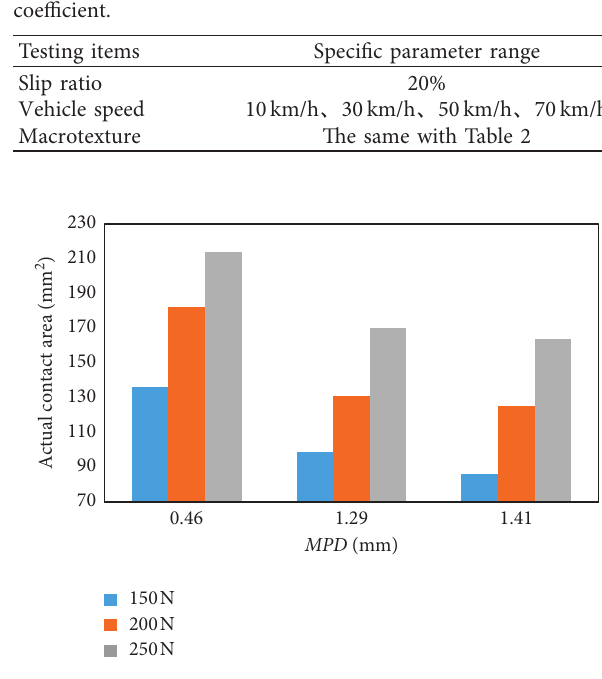
Figure 3: The actual contact area based on different MPD.